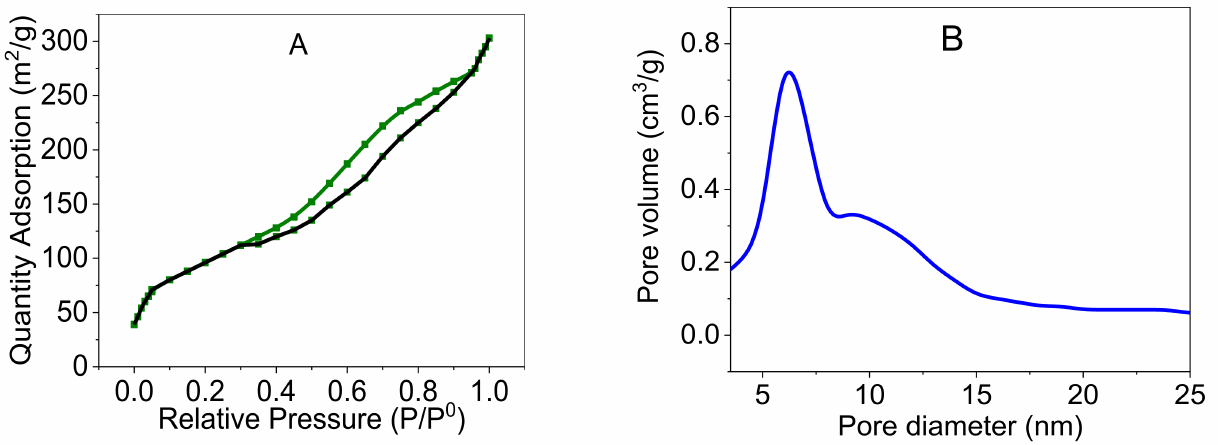
Figure 8. Nitrogen adsorption and desorption isotherms ( A ), and pore size distribution of Pd@C–PS ( B